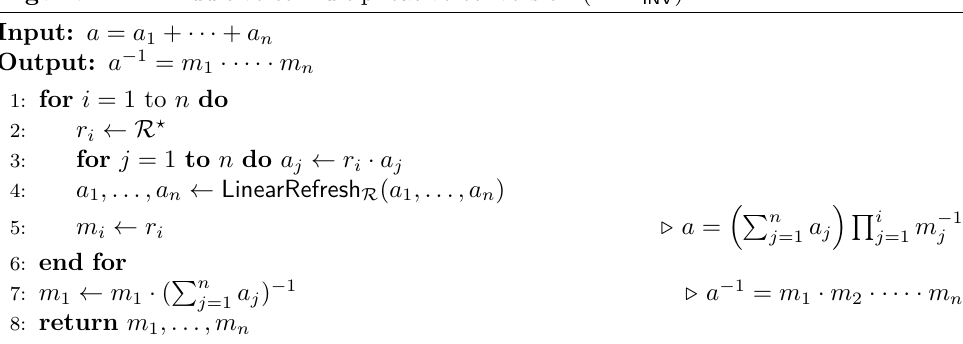
Algorithm 12 Additive to multiplicative conversion ( A2M INV )